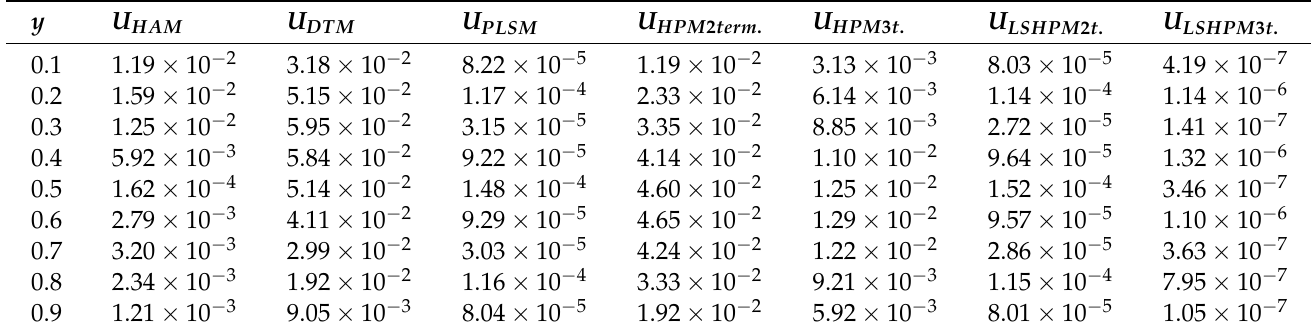
Table 3. Comparison of the absolute errors of the approximate solutions for U for the case Re = 1 and Ha = 1.